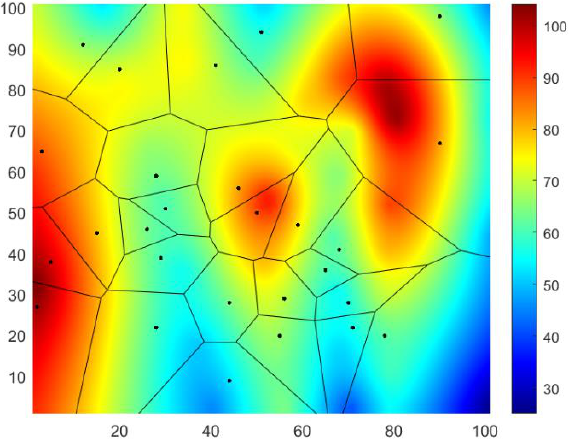
Figure 5. Voronoi diagram division on the elevation map.